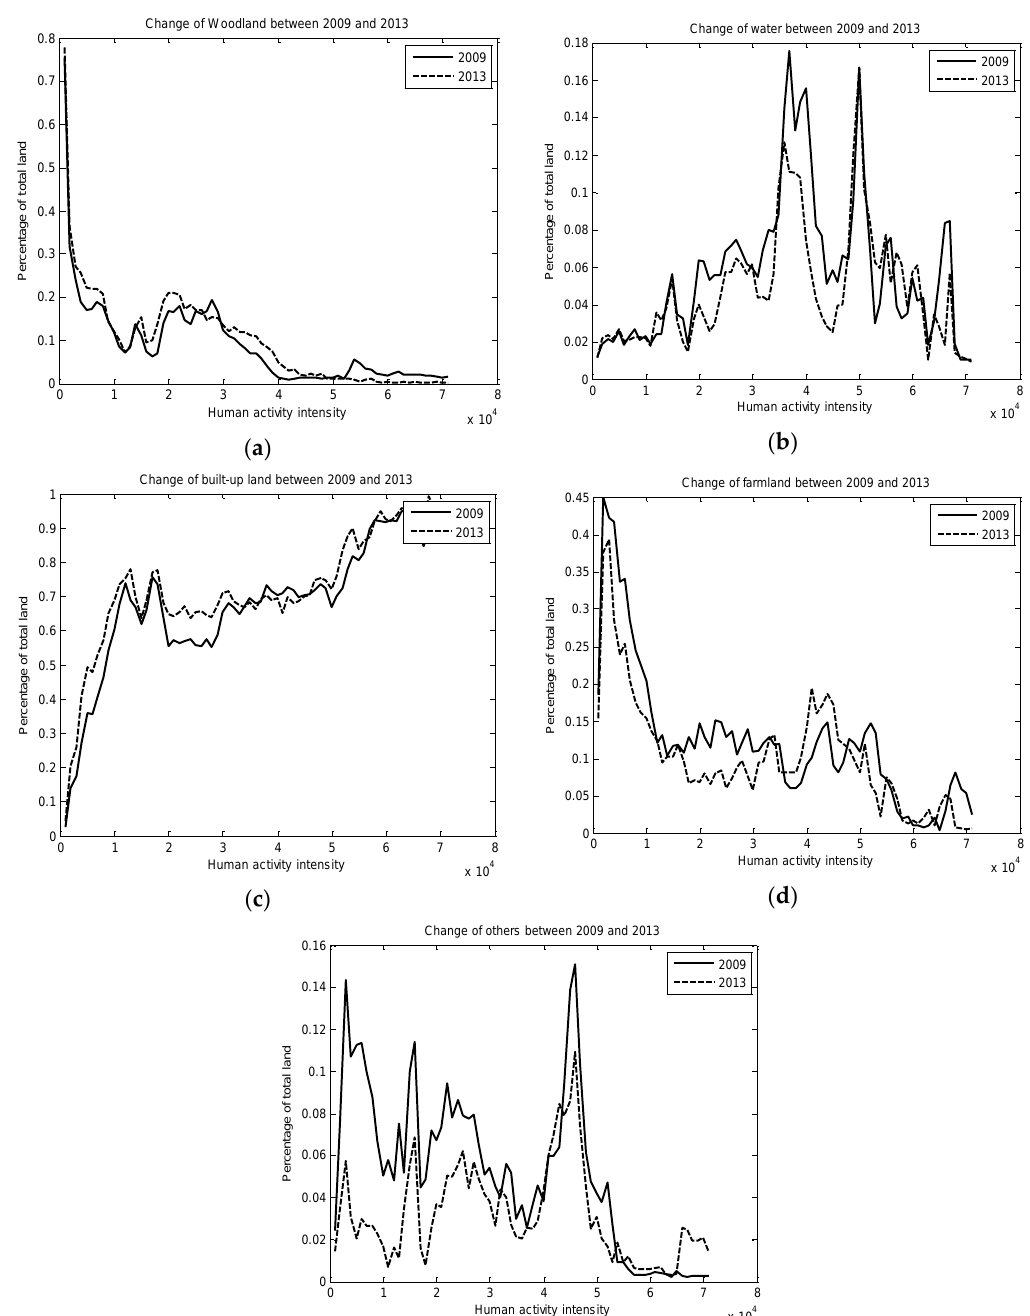
Figure 7. Change of land percentage with human activity intensity between 2009 and 2013. ( a ) Woodland; ( b ) water; ( c ) built-up land; ( d ) farmland; ( e ) others.